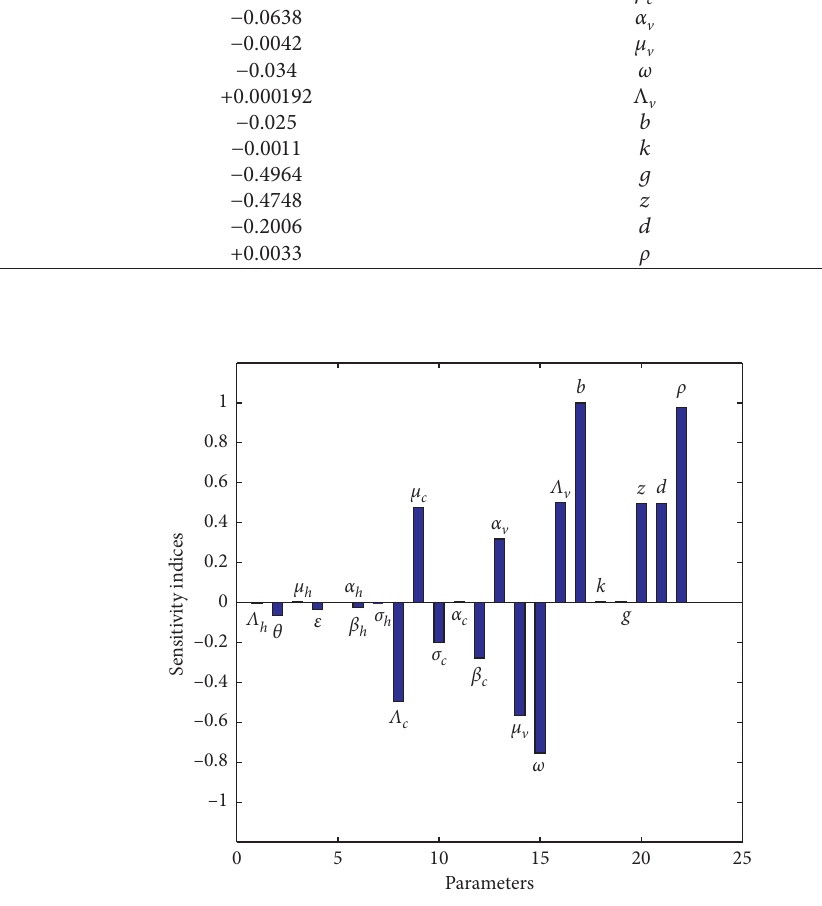
Figure 2: Sensitivity analysis of R